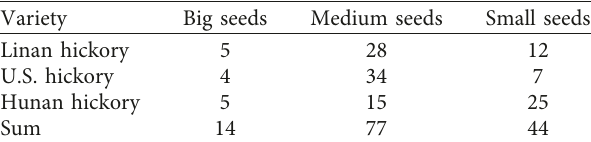
Table 2: Source and distribution of